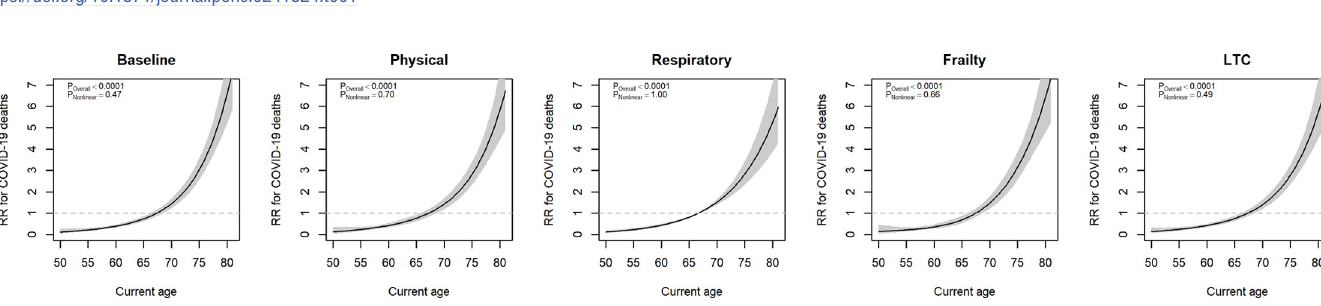
PLOS ONE | https://doi.org/10.1371/journal.pone.0241824 November5,